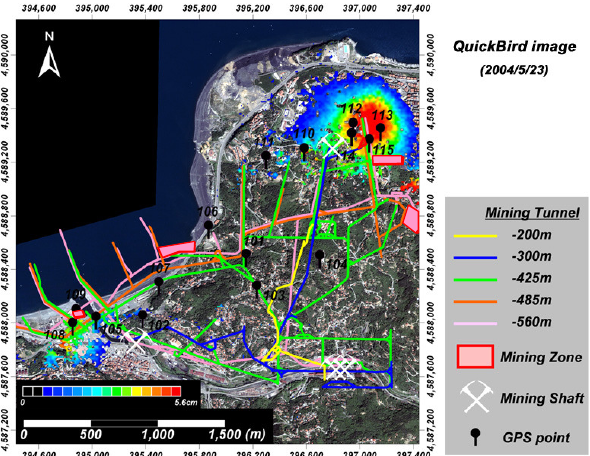
Figure 10. InSAR deformation map, digitized mine production map and Quickbird Orthoimage combined in GIS